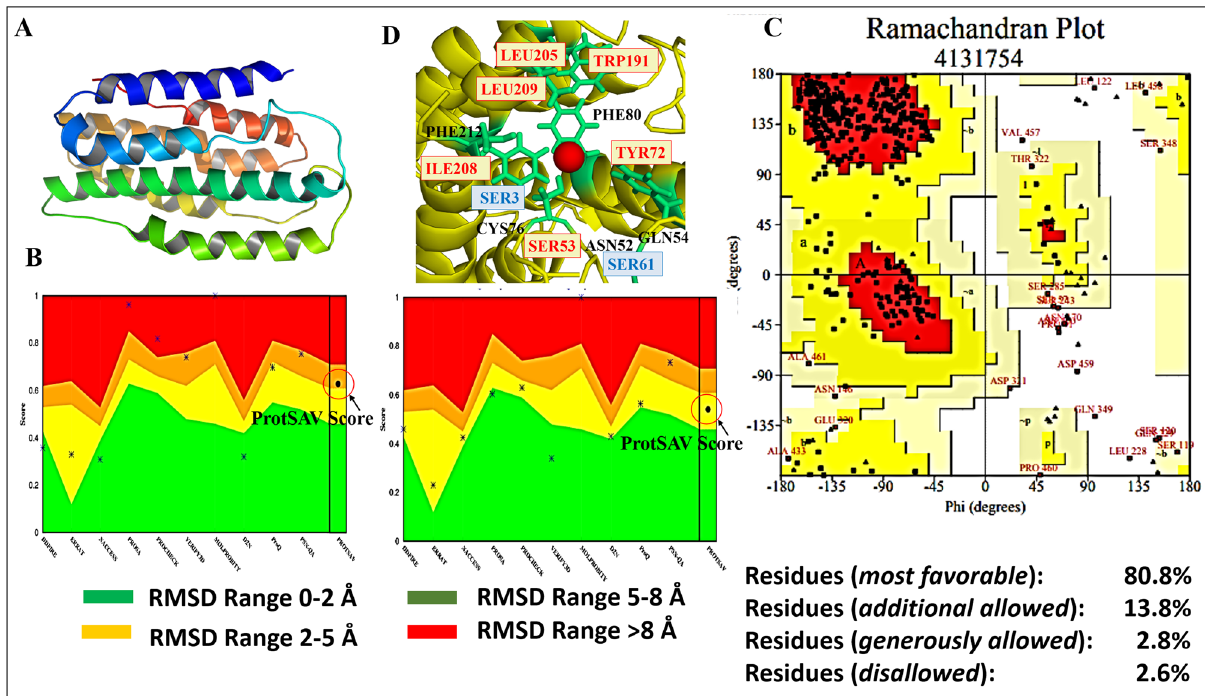
Figure 1. ( A ) The final selected structure of HBsAg obtained after structural refinement. ( B ) ProTSAV scores found earlier in the range from 5 to 8 Å and 2–5 Å after iterative refinement steps. ( C ) Ramachandran Plot for the selected final structure of HBsAg. ( D ) Active Site predicted for HBsAg via AADS showing its nearby